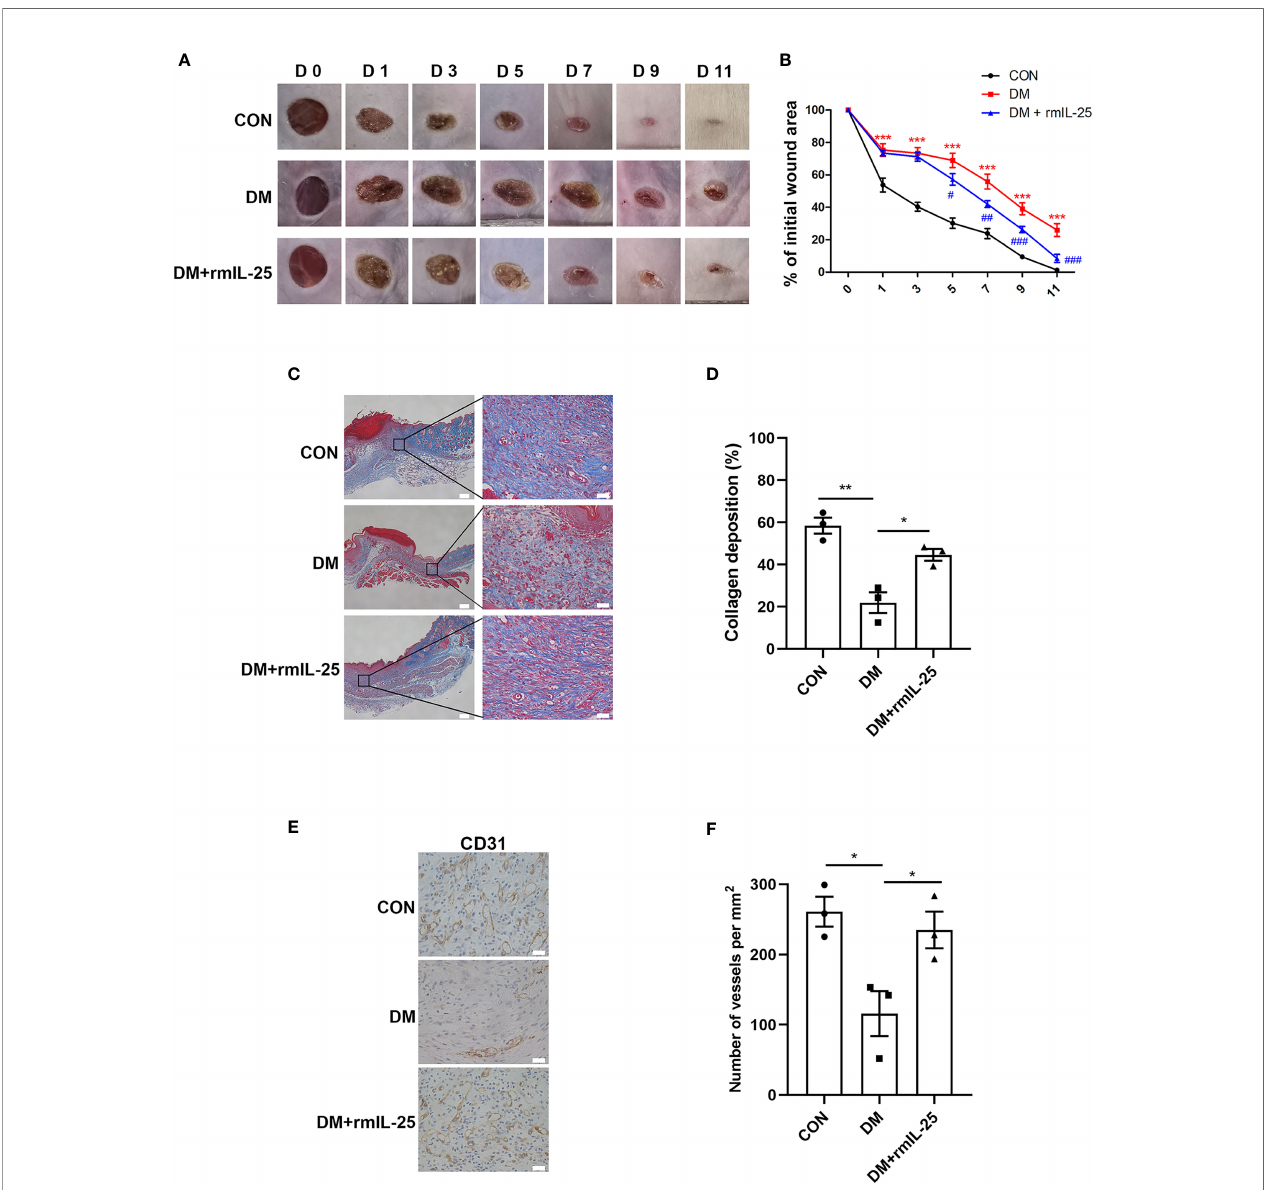
FIGURE 3 | IL-25 promotes wound healing by improving angiogenesis and collagen deposition in diabetic mice. Full-thickness wounds were made on the dorsum of control (CON) and diabetic mice, and the wounds were treated locally with PBS (DM group) or rmIL-25 (DM + rmIL-25 group) on days 0, 1, 2, 4 and 6 after injury. (A, B) Wound area analysis showed ameliorated healing in diabetic mice treated with rmIL-25 and the healing is shown as the percentage of the initial wound area. (A) Representative wound images at days 0, 1, 3, 5, 7, 9 and 11 during the healing process. (B) Quanti fi cation results of wound areas are shown (n = 5) (*, DM vs CON group; #, DM + rmIL-25 vs DM group). (C, D) Masson trichrome staining of wound skin (day 7 post injury) revealed improved collagen deposition in diabetic mice treated with rmIL-25 (C) and the statistical analysis was shown in D (n = 3, three views for each sample). Scale bars, 200 m m (left), 25 m m (right). (E) Levels of angiogenesis (vessel density) were evaluated by immunohistochemistry staining for CD31 in wound skin sections (day 7 post injury) from groups of CON, DM and DM + rmIL-25. Scale bars, 25 m m. (F) Quanti fi cation of the vessel numbers in D is presented (n = 3, three views for each sample). * and # P < 0.05, ** and ## P < 0.01, *** and ### P <